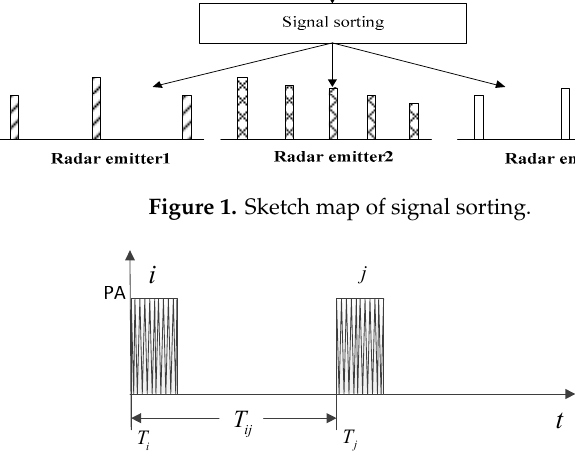
Figure 1. Sketch map of signal sorting.